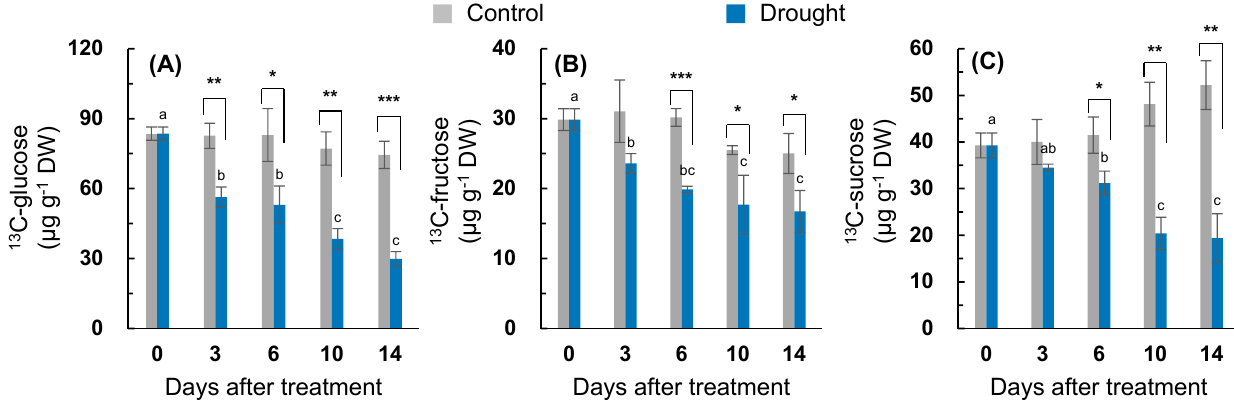
Figure 3. Changes in the amount of newly fixed C assimilated into ( A ) glucose ( 13 C-glucose), ( B ) fructose ( 13 C-fructose), and ( C ) sucrose ( 13 C-sucrose) in the leaves of the well-watered control or drought-stressed plants during 14 days of treatment. Data are presented as the mean ± SE for n = 4. Bars labeled with different letters in the drought-stressed plants are significantly different at p < 0.05, according to Duncan’s multiple range test. Asterisks denote a statistical difference between the drought treatment and control: * p < 0.05, ** p < 0.01, and *** p < 0.001.